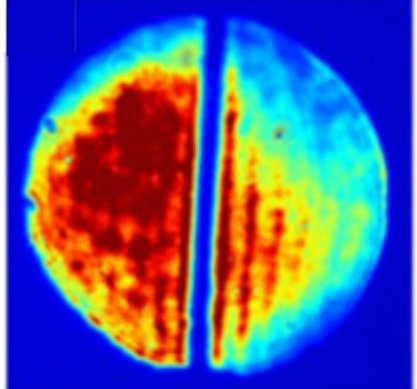
Figure 7. Near-field spatial distribution in PW laser system.